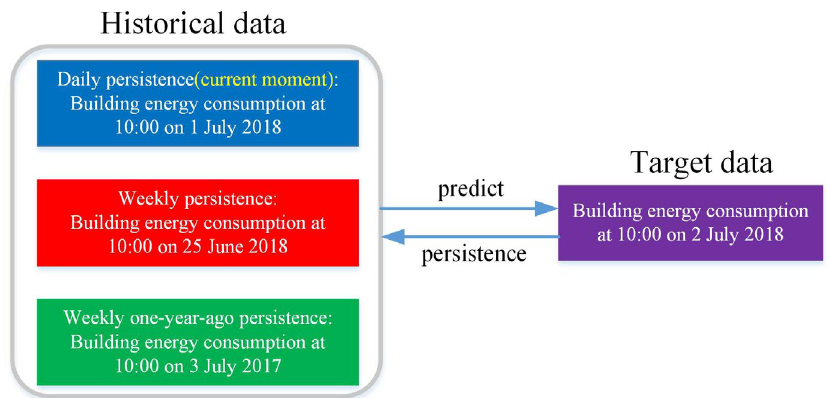
Figure 3. Periodicity of energy consumption data.